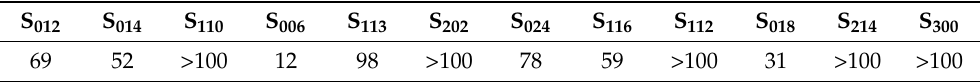
Table 1. Apparent nanocrystal sizes, S hlk (in nm), from the Scherrer’s formulae for LN nanoplatelets after thermal decomposition of lithium niobium ethoxide in its parent alcohol for 3 days at 230 ◦ C. S